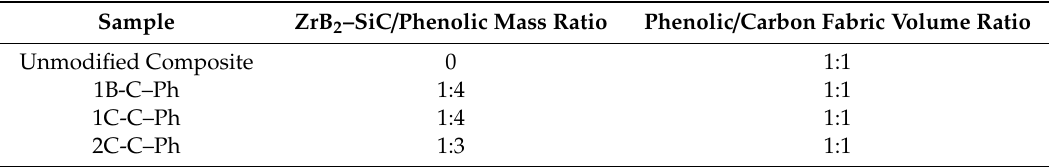
Table 2. The mass proportion of the C–Ph composite